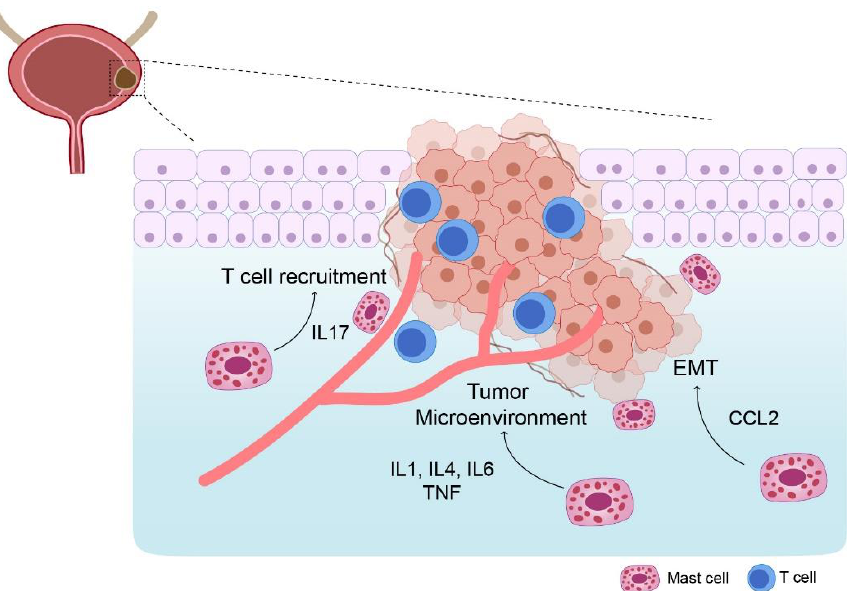
Figure 2. Modulation of bladder cancer by mast cells. Activated MCs can amplify the tumor microenvironment’s dysregulated tissue homeostasis and promote tumor development. MCs in the tumor microenvironment enhance epithelial-mesenchymal transition induction. Mast cells contribute anti-tumor immunity by mobilizing and activating immune cells. Tumor-infiltrating MCs directly affect the aggressiveness of a tumor cell. However, they indirectly function inside the TME by interacting with other immune cells and pro- moting or suppressing immunological responses [15,25,40]. Since the MCs interact with immune suppressor cells, such as MDSCs and Tregs, they can substantially influence the development and functional capability of tumor immunity [15,19,55–61]. For example, MDSCs are recruited to tumor locations by CCL2 and potentially CXCL1 and CXCL2, where direct contact with MCs or with histamine increases their inhibitory function [19,55]. The MC stimulates the production of IL-17 via MDSC, mobilizing Tregs and en- hancing their suppressive activity on cytotoxic T cell [19,57]. Subsequently, IL-17 indi- rectly recruits Tregs and increases their suppressor function and stimulates IL-9 produc- tion, thus enhancing the pro-tumorigenic function of the MCs in the TME [19,57]. Remark- ably, TGF-β and IL-10 produced by the MCs promote the development of Tregs, down- regulate expression of costimulatory molecules in DCs, and reduce the production of pro- inflammatory cytokines by TAMs. They also suppress antigen-specific T cell responses